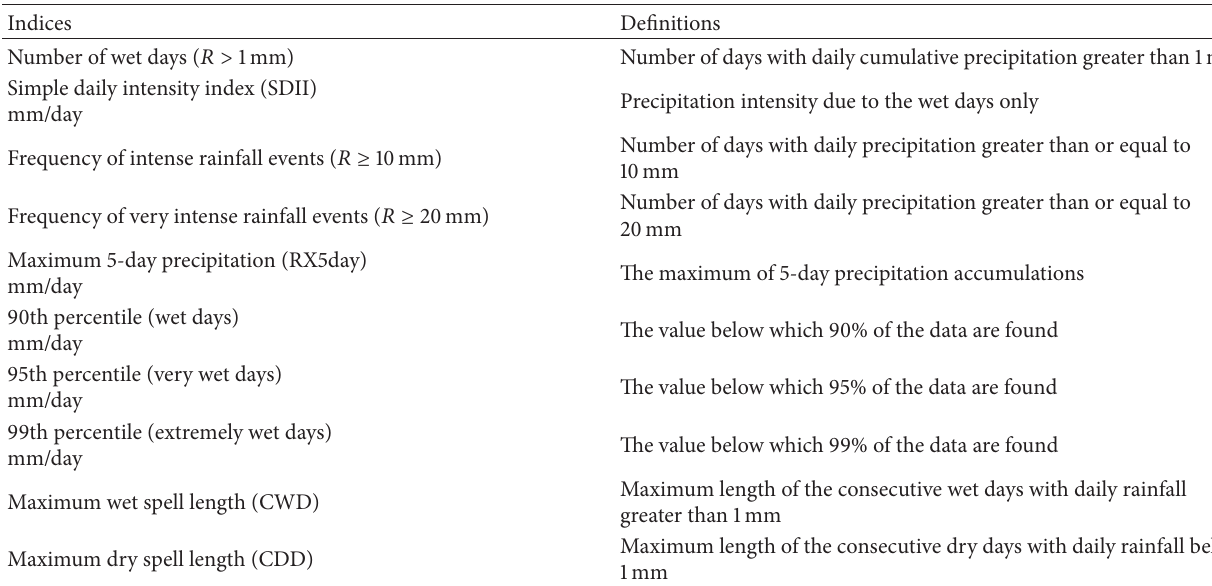
Table 2: Definition of climate